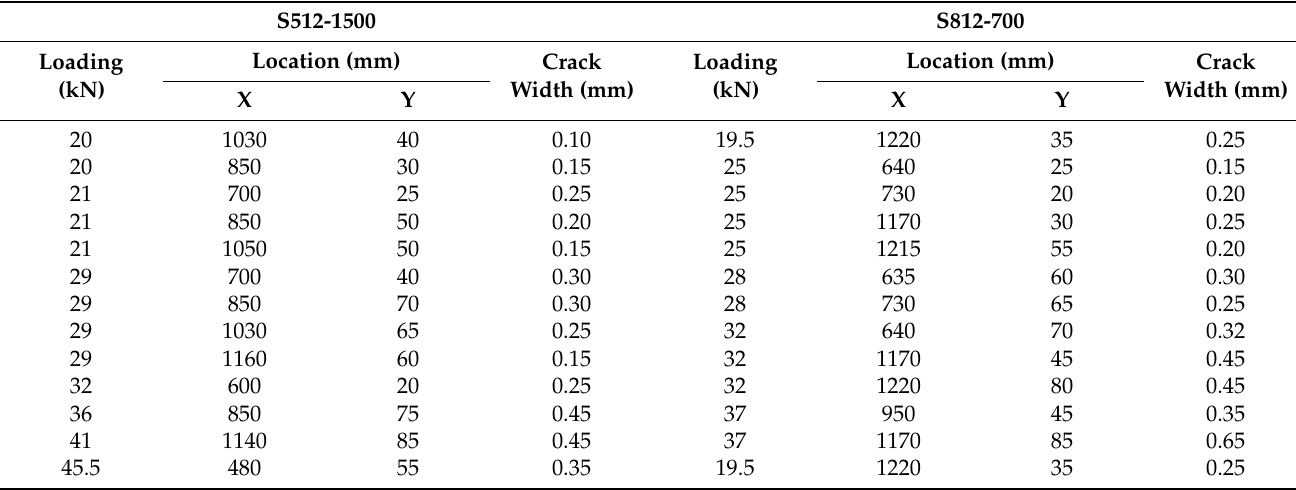
Table 10. Crack widths and their locations for the S512-1500 and S812-700